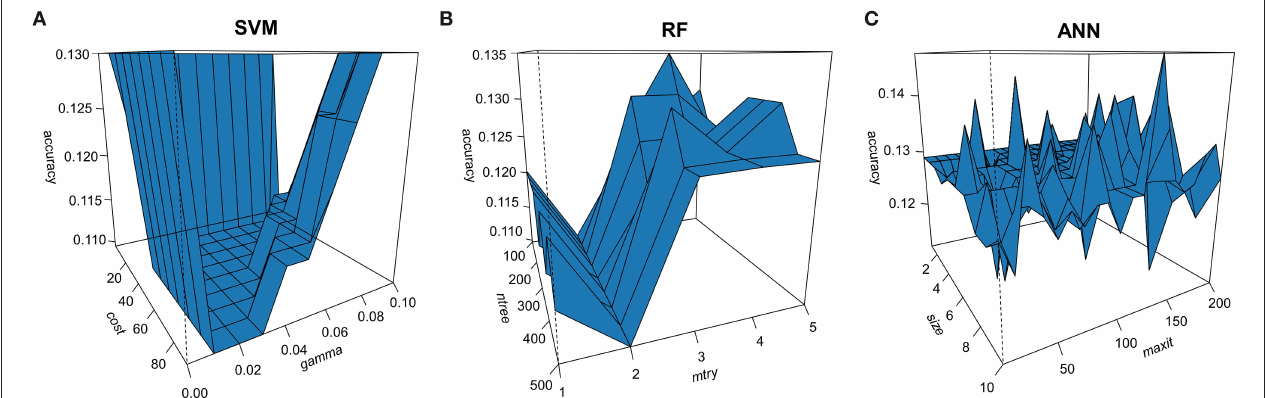
FIGURE 2 | Perspective view of the outcomes in hyper-parameter tuning. The 10-fold cross-validation and grid search were used to obtain optimal hyper-parameters for three machine learning models. (A) The constraints violation cost ( cost ) and gamma parameter ( gamma ) in the support vector machine (SVM) model. (B) The number of trees to grow ( ntree ) and variables randomly sampled as candidates at each split ( mtry ) in the random forest (RF) model. (C) The number of hidden units ( size ) and the maximum number of iterations ( maxit ) in the artificial neural network (ANN)